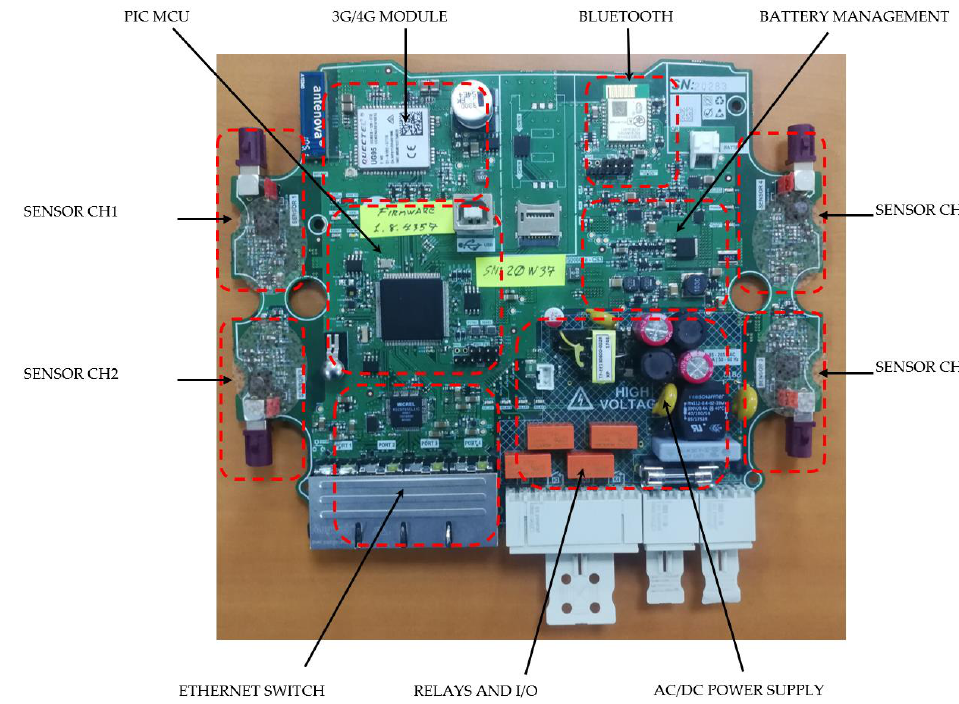
Figure 3. CEMF sensor board.